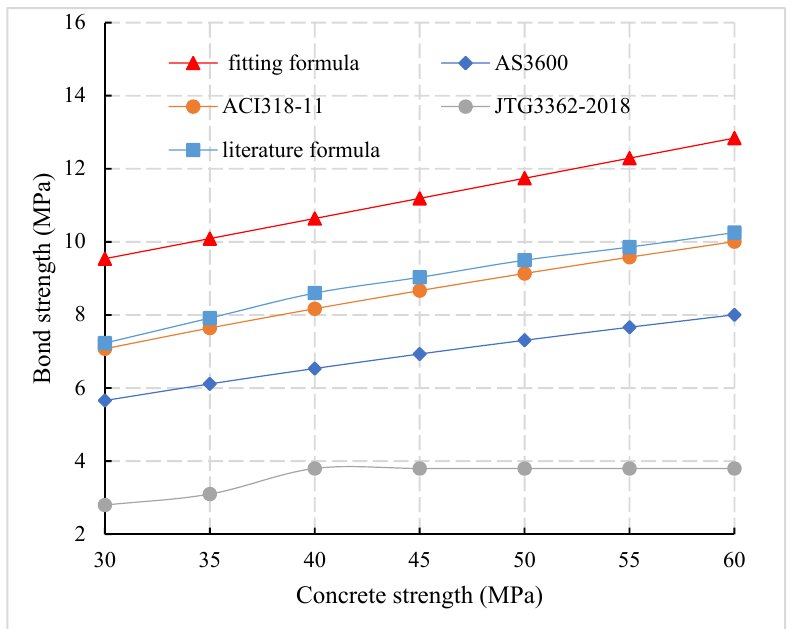
19 of 24 Figure 16. Comparison curve between fitting value and test value of bond strength. Taking the diameter of a steel bar, 25 mm, and the thickness of the protective layer 85 mm commonly used in the connection of prefabricated concrete members as an exam- ple, the differences of bond strength calculation between domestic and foreign codes and the fitting formula in this paper are shown in Figure 17. It can be observed that the bond strength calculation value of ACI 318-11 [34] is 25% and 15.9% higher than that of AS3600 [33] and JTG 3362-2018 [27], respectively, and this indicates that there are some differences